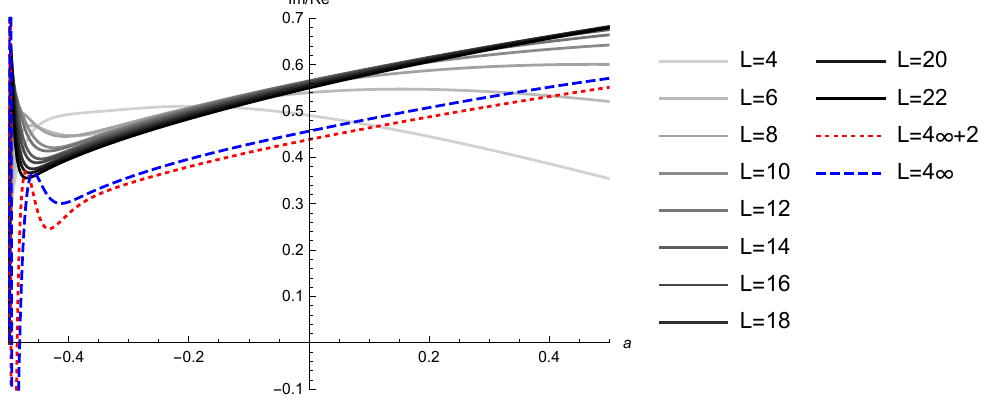
Figure 16 . Plots of Im / Re (2.22) for the “ghost brane” solution Φ G horizontal axis denotes the value of the parameter a